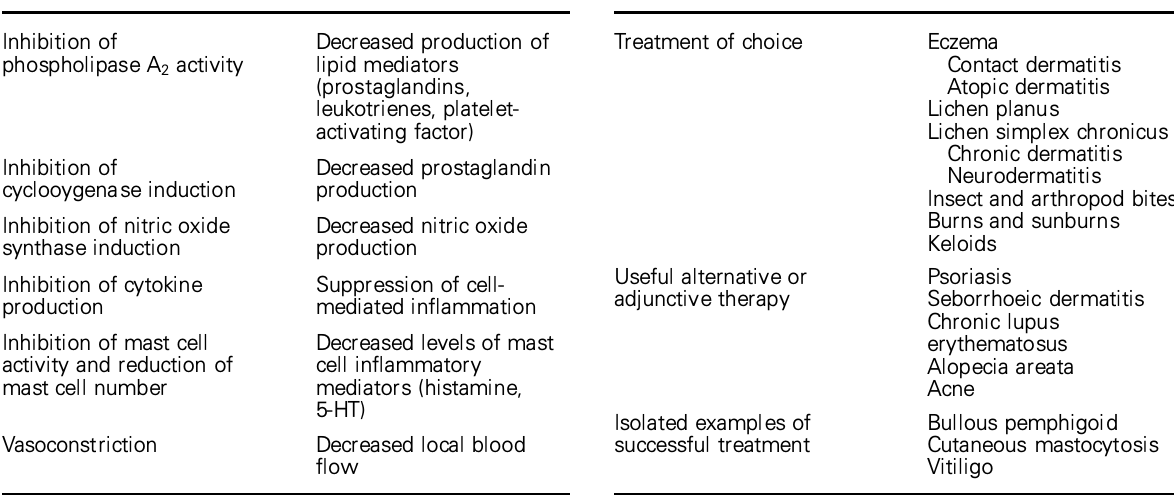
Table 1. Mechanisms of anti-inflammatory action of the topical glucocorticoids Action